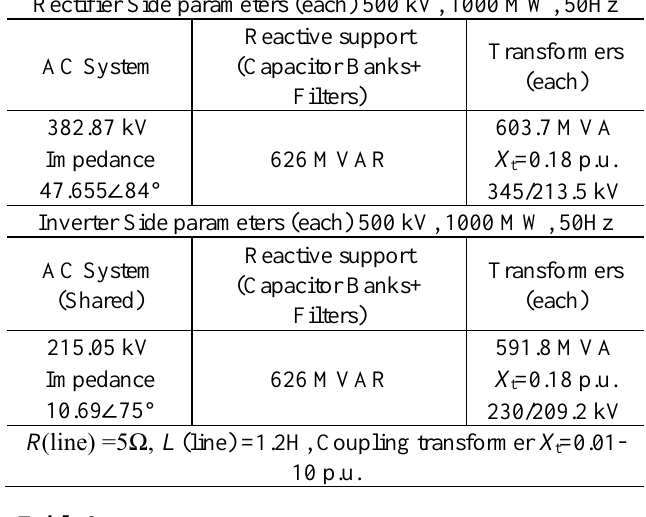
Multi-Infeed HVDC parameters Rectifier Side parameters (each) 500 kV, 1000 MW, 50Hz